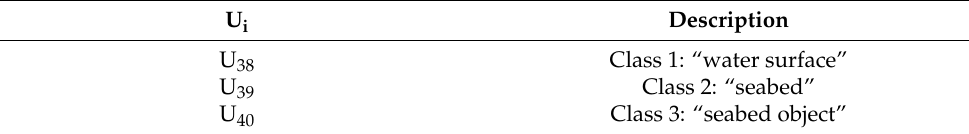
Table 2. Description of outputs from the